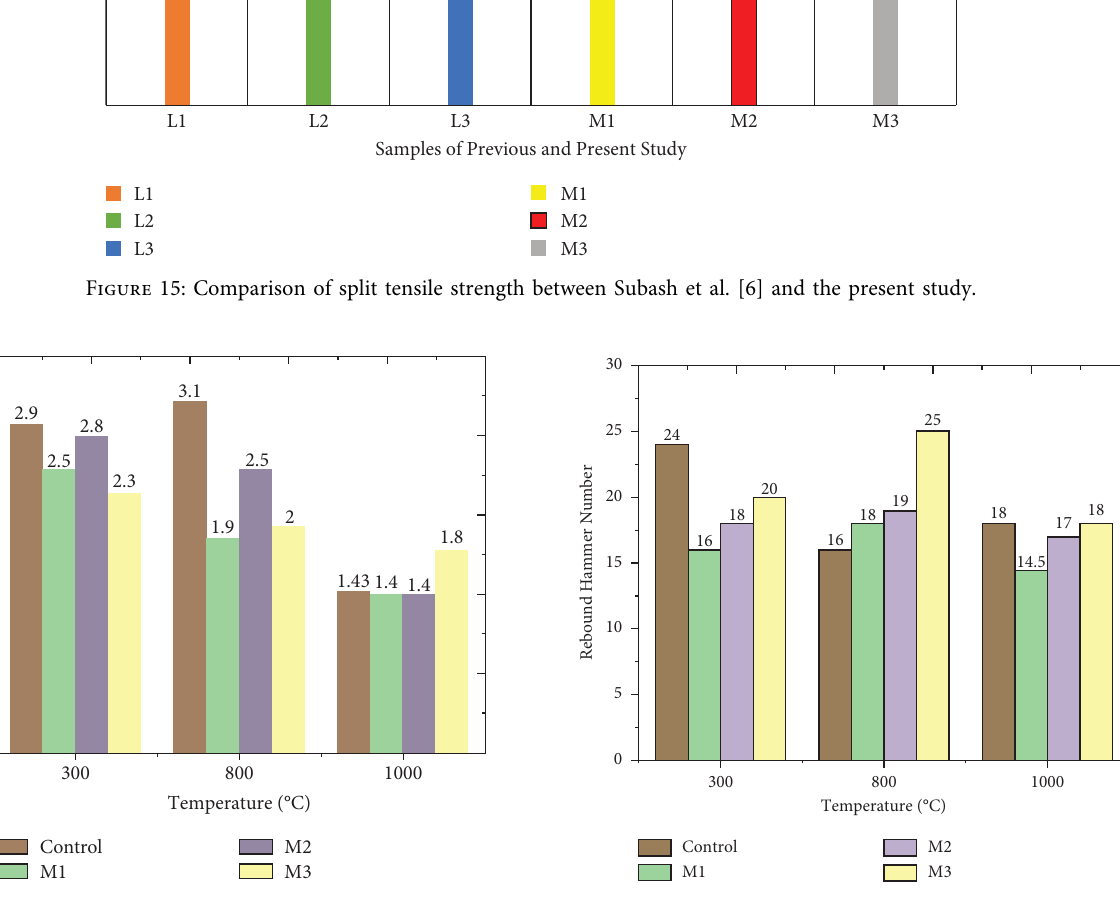
Figure 16: Split tensile strength of postheated concrete. Figure 17: Rebound number value of postheated concrete cylinder